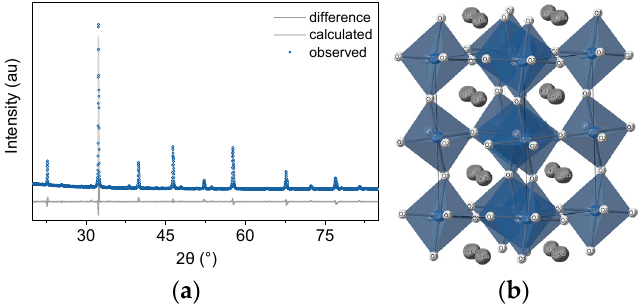
Figure 2. Preparing a single-phase perovskite capable of exsolving exo- and endo-particles. ( a ) Rietveld refinement (wR 9%) of the room-temperature XRD pattern of the La 0.8 Ce 0.1 Ni 0.4 Ti 0.6 O 3 perovskite after sintering at 1400 °C for 15 h. ( b ) Crystal structure corresponding to the perovskite obtained by refinement (space group Pnma, a = 5.54067 Å, b = 5.52939 Å, c = 7.818 Å).